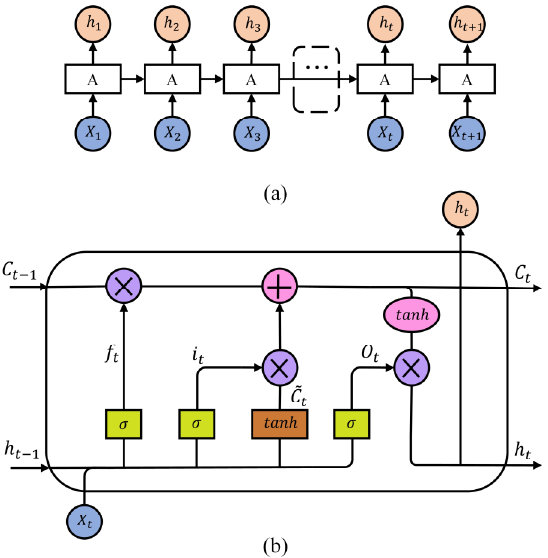
Figure 5. ( a ) LSTM network model structure; ( b ) LTSM cell structure.